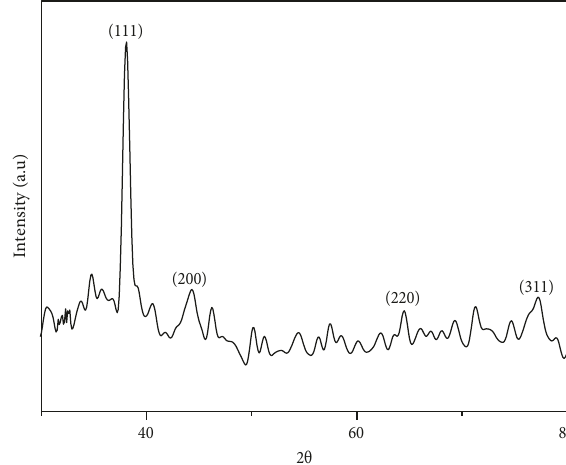
Figure 3: XRD for synthesized silver nanoparticles using the Pisonia Alba leaf